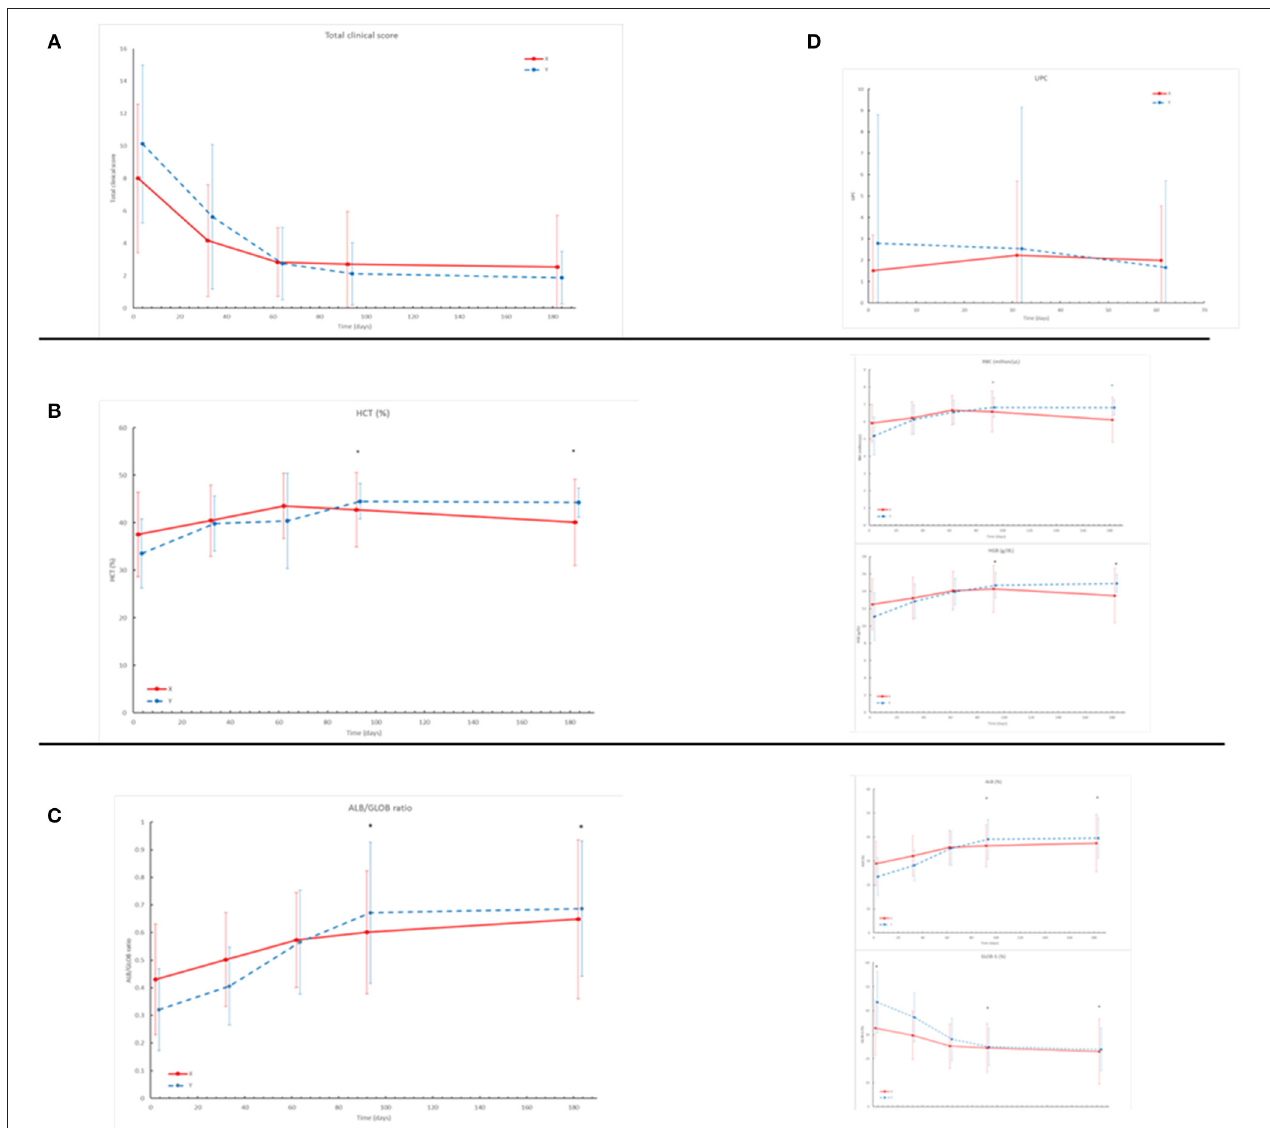
FIGURE 1 | (A) The Clinical Score shows severe reduction throughout the study in both groups (X red line, Y blue line). No statistical differences were registered between the two groups (B) HCT%, Hb (g/dl), RBC ( × 10 6 /ml) registered in the two groups throughout the study. The asterisk shows statistical differences (D90, D180): HCT%: P = 0.0005 RBC: P < 0.0001 Hgb: P = 0.0001. (C) Albumin/globulin ratio, Albumin%, Globulin% registered in the two groups throughout the study. The asterisk shows statistical differences (D90/D180): Alb/Glob: P = 0.01; Alb%: P = 0.004; Glob%: P = 0.003. (D) Results of UPC at urinalysis showed a trend